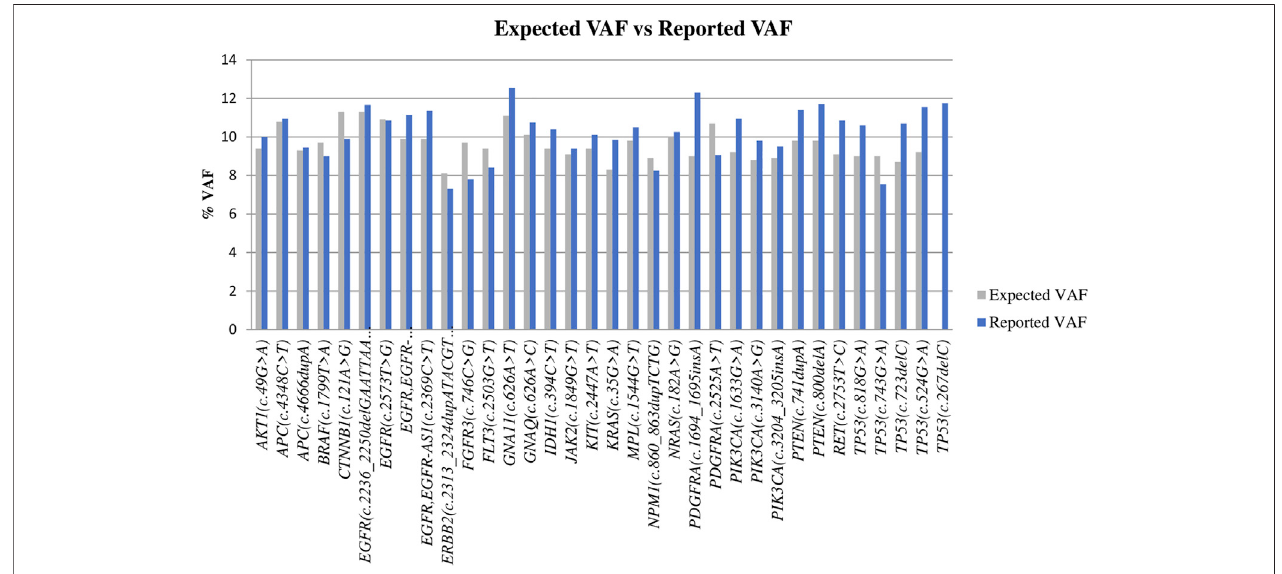
FIGURE 2 | Comparison of the expected VAF and the mean VAF obtained for the different variants. For TP53 (c.267delC), the graphic only shows the value of the reported VAF, as the commercial company did not specify the expected VAF for this variant.